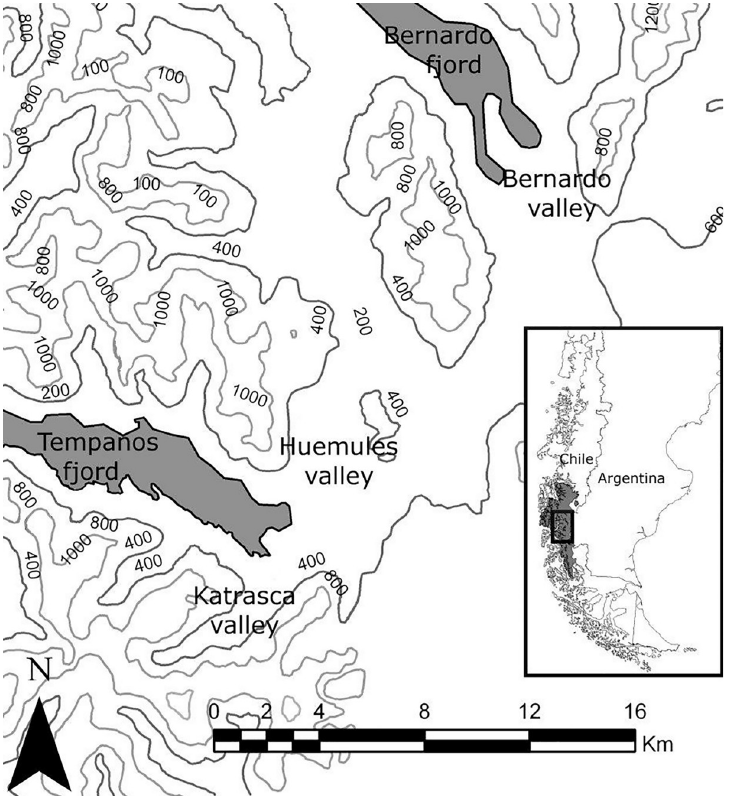
Fig 1. Study area in Bernardo O’Higgins National Park. Locations of the Bernardo, Huemules and Katraska Valleys in the Te´mpanos and Bernardo Fjords, and elevation contours in m above sea level (a.s.l). The shaded area on the inset indicates the location of the Park, and the rectangle the location of the main map, in